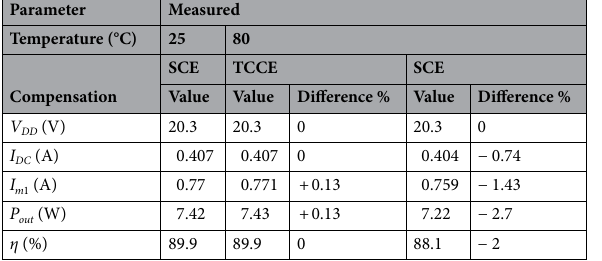
Table 5. The values of the measured parameters in the state with and without compensation circuit at 80 °C.